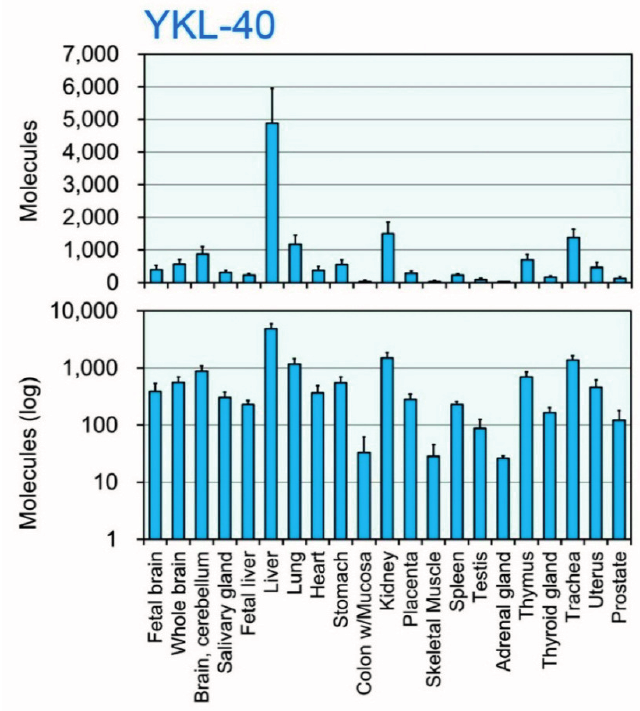
Figure 3. The expression of YKL-40 mRNA in normal human tissues. The expression levels of YKL-40 were quantified by qPCR using human Refs/YKL-40 standard DNA. The y